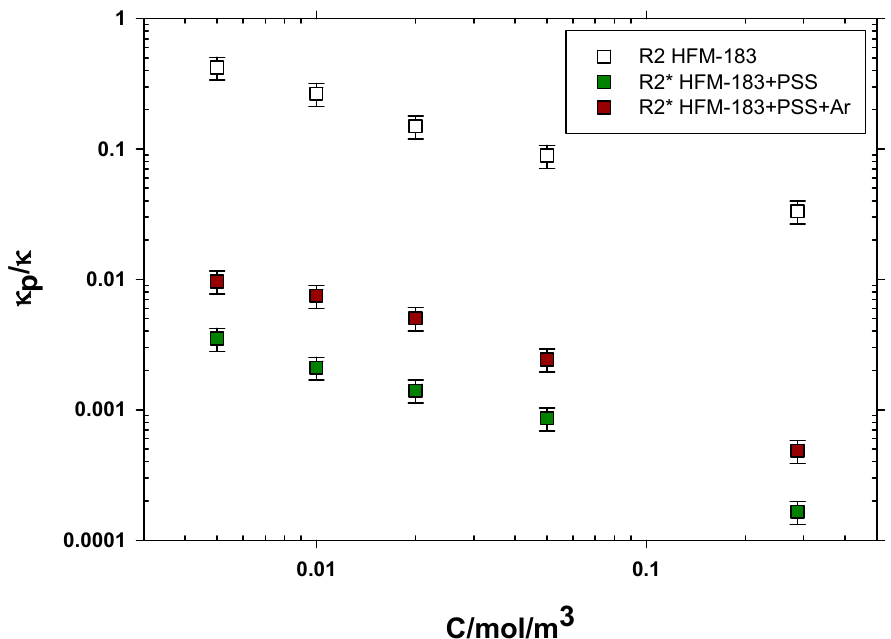
Figure 9. Conductivity through the active layer pores relative to the free solution conductivity as a function of K 2 CrO 4 concentration for the HFM-183, HFM-183+PSS, and HFM-183+PSS+Ar membranes.